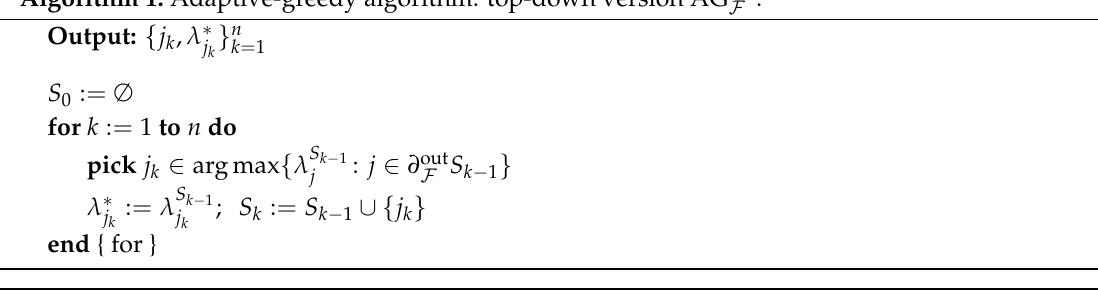
Algorithm 1: Adaptive-greedy algorithm: top-down version AG TD F .